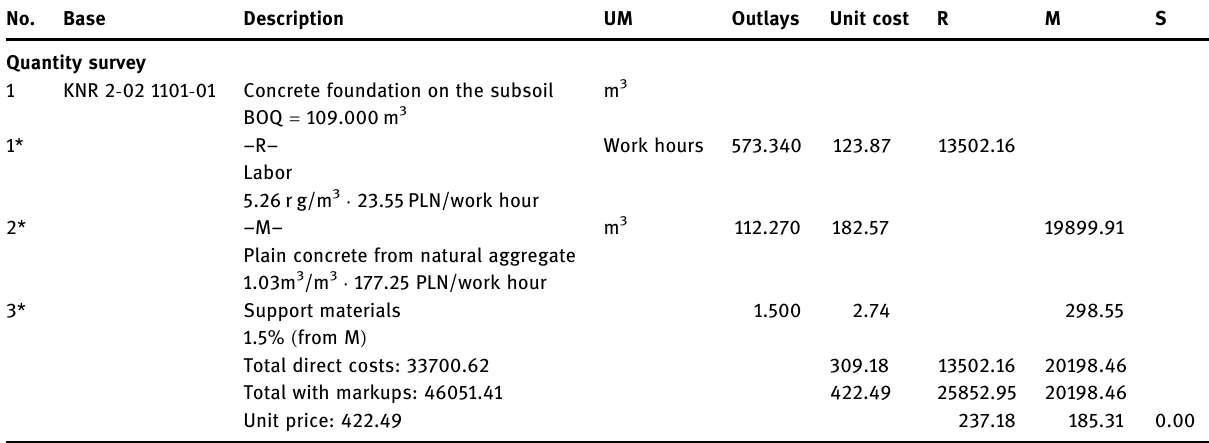
Table 3: The value of the increase in the price of the jet grouting columns based on the Norma - Pro program No.